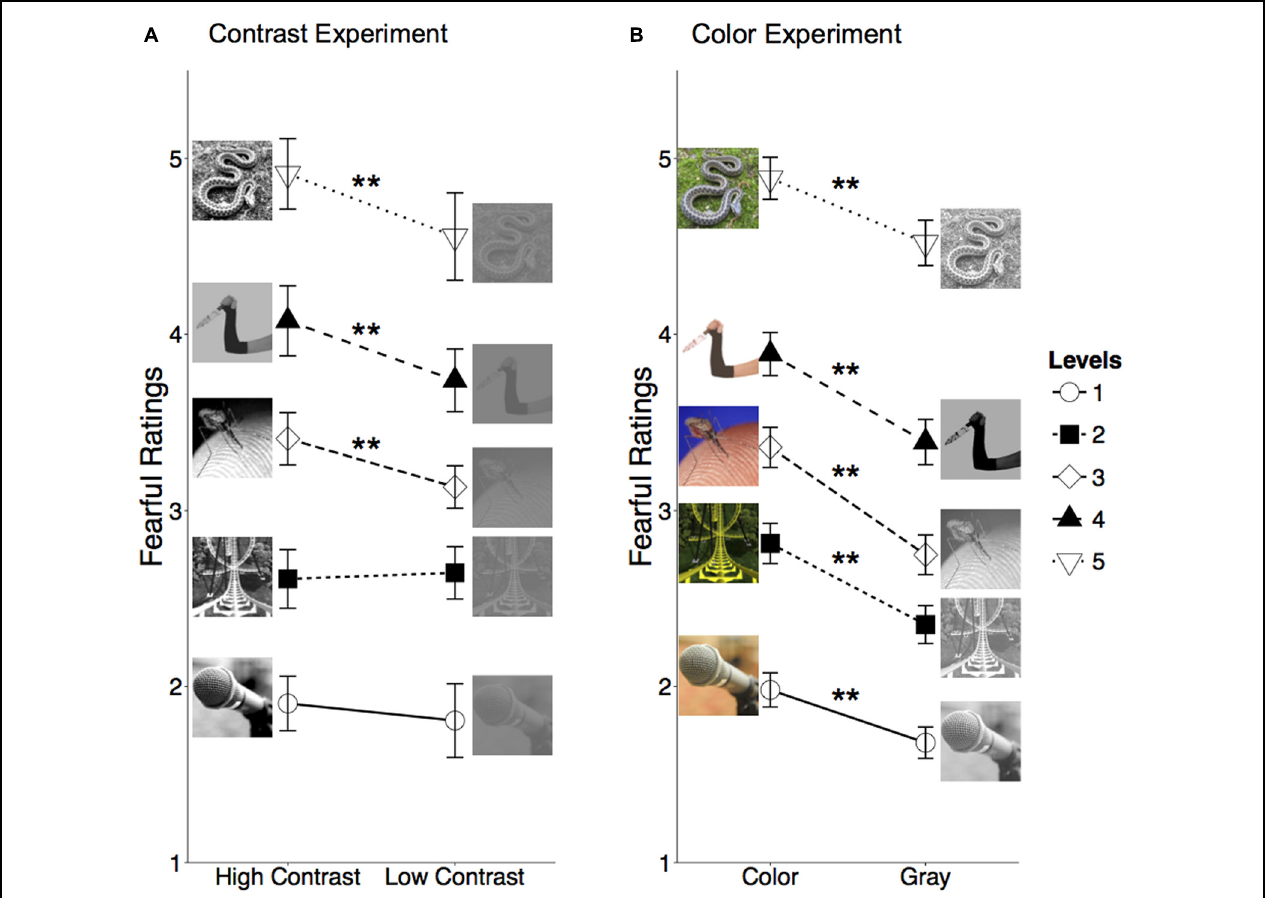
FIGURE 1 | Mean fearful ratings for (A) high contrast and low contrast images at five levels of fearfulness in the contrast experiment and (B) color and gray images at five levels of fearfulness in the color experiment. Error bars represent 95% confidence intervals. Examples of stimuli at each level of fearfulness are shown next to the corresponding data point for each experimental condition. ∗∗ indicates p < 0.01, Bonferroni